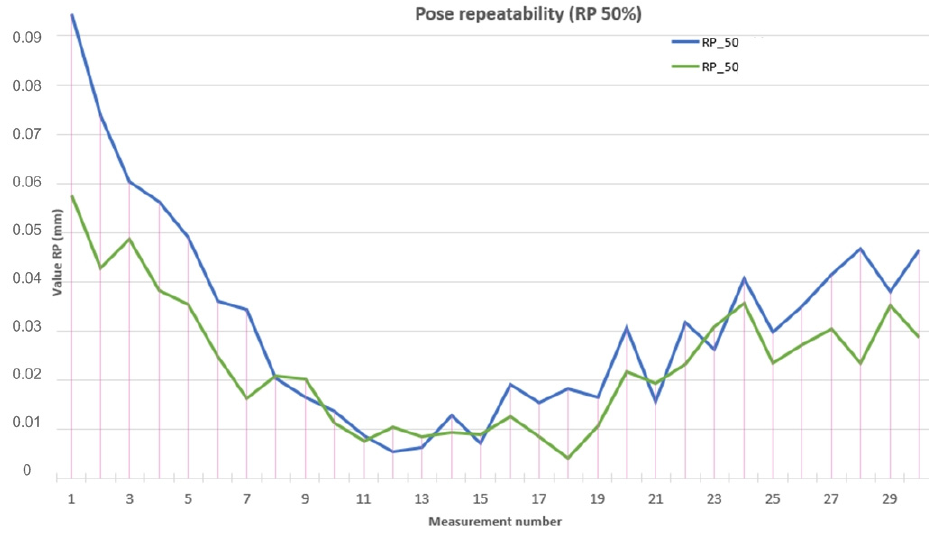
Figure 7. Plotted RP comparison under half the load.